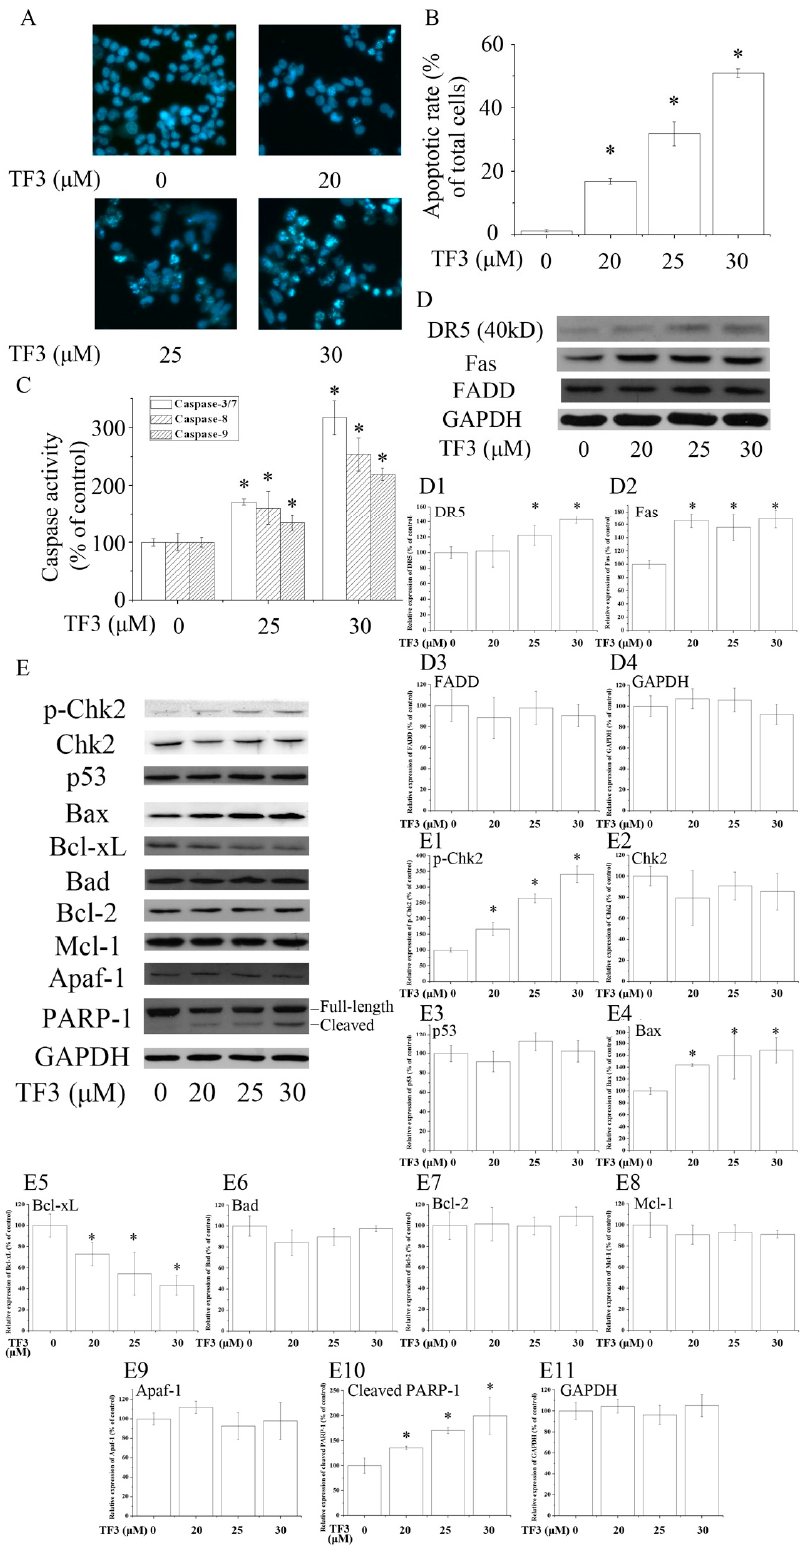
Figure 2. Theaflavin-3,3 (cid:48) -digallate (TF3) induced apoptosis in human ovarian carcinoma (OVCAR-3) cells. ( A , B ) Hoechst 33342 staining assay. ( C ) TF3 activated caspases in OVCAR-3 cells. ( D , E ) TF3 influenced apoptosis-related proteins. ( D1 – D4 & E1 – E11 ) Densitometry analysis of protein bands. Glyceraldehyde-3-phosphate dehydrogenase (GAPDH) served as a loading control. * p < 0.05 compared with the control